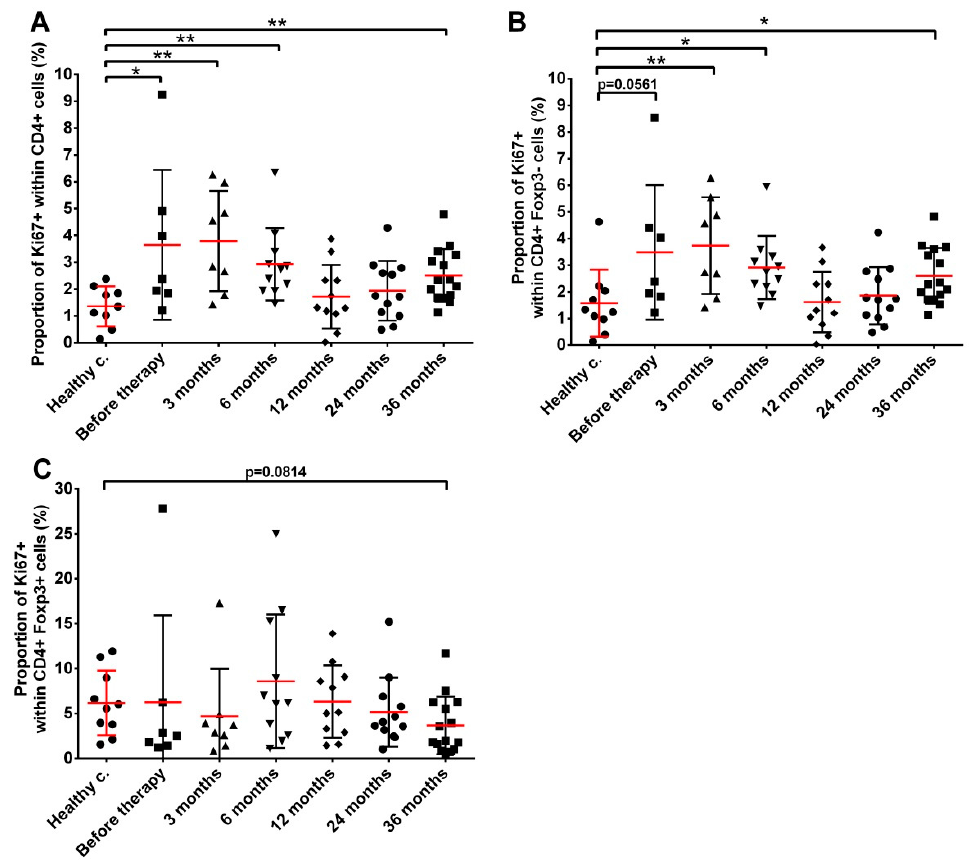
Figure 5. The fraction of proliferating CD4+ T cells was higher in prostate cancer patients compared to healthy controls. ( A ) Proliferating CD4+ cells; ( B ) Proliferating CD4+ effector T cells; ( C ) Proliferating Treg cells. Blood collection, processing and immune phenotyping were carried out as described in the Materials and Methods at the indicated time points relative to brachytherapy. n (healthy controls) = 10, n (cancer patients) = 8–18. Significant differences were indicated with * ( p < 0.05) and ** ( p <